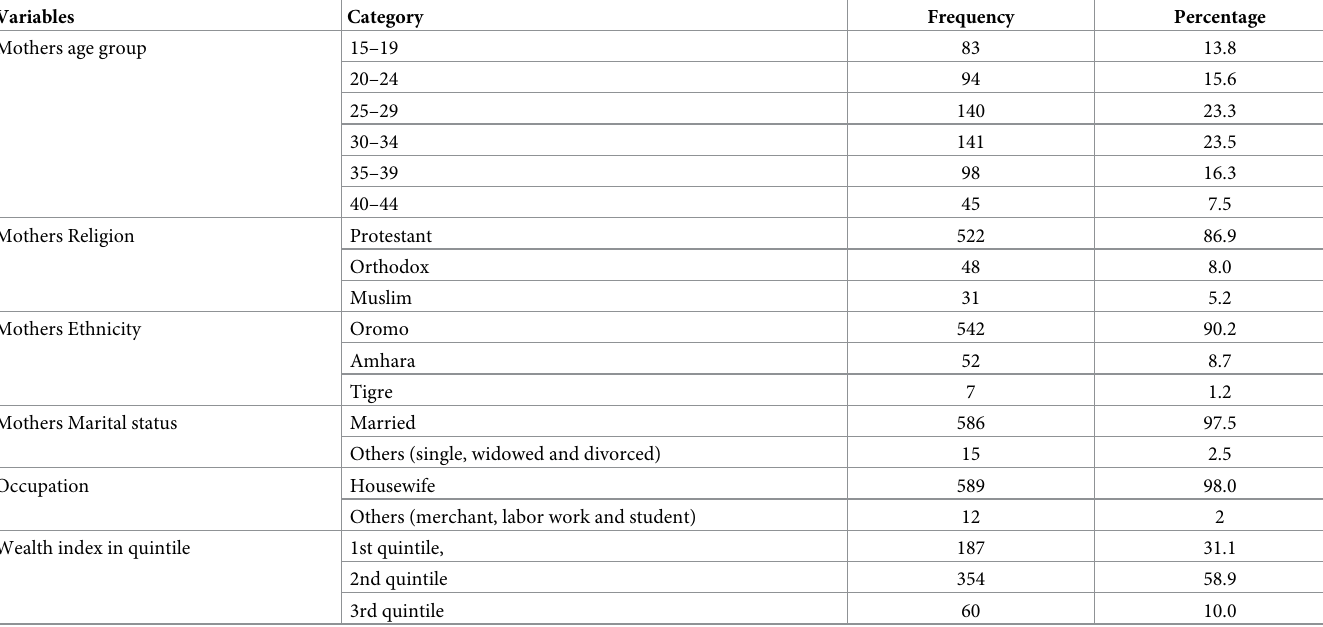
Table 1. Socio-demographic and economic characteristics among home delivered women, in Guto Gida district, Oromia, September 2020 (n = 601). Variables Category